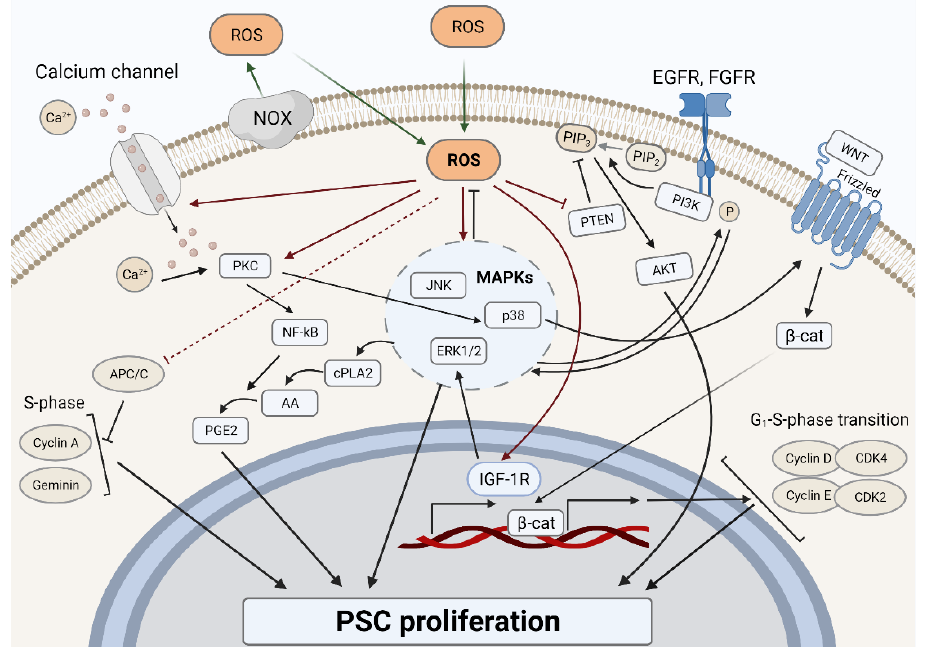
Figure 2. Overview of ROS-dependent signaling cascades involved in PSC proliferation regulation. ROS, reactive oxygen species; NOX, NADPH oxidase; FGFR, fibroblast growth factor receptor; EGFR, epidermal growth factor receptor; PKC, protein kinase C; NF-kB, nuclear factor kappa-light-chain-enhancer of activated B cells; cPLA2, phospholipase A2; AA, arachidonic acid; PGE2, prostaglandin E2; APC/C, anaphase-promoting complex/cyclosome; MAPK, mitogen-activated protein kinase; ERK, extracellular signal-related kinases; JNK, c-Jun N-terminal kinases; p38, p38 kinase; AKT, protein kinase B; MAPK, mitogen-activated protein kinase; PTEN, phosphatase and tensin homolog deleted on chromosome 10; PI3K, phosphatydylinositol-4,5-bisphosphate 3-kinase; PIP3, phosphatidylinositol 3,4,5-triphosphate; PIP2, phosphatidylinositol 4,5-bisphosphate; β-cat, β-catenin; IGF-1R, insulin-like growth factor 1 receptor; CDK, cyclin-dependent kinase; PSC, pluripotent stem cell.